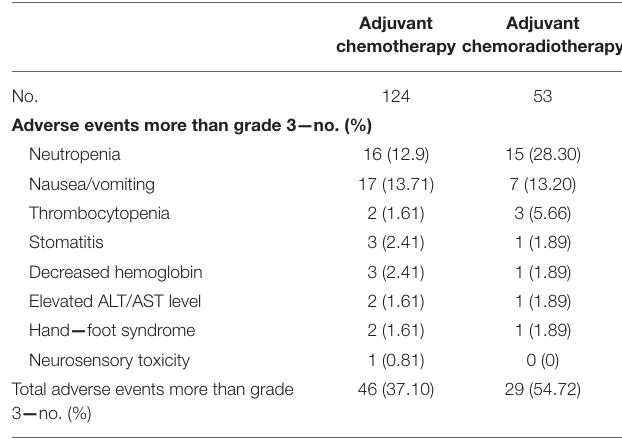
TABLE 4 | Adverse events used in the decision model, according to treatment therapy.